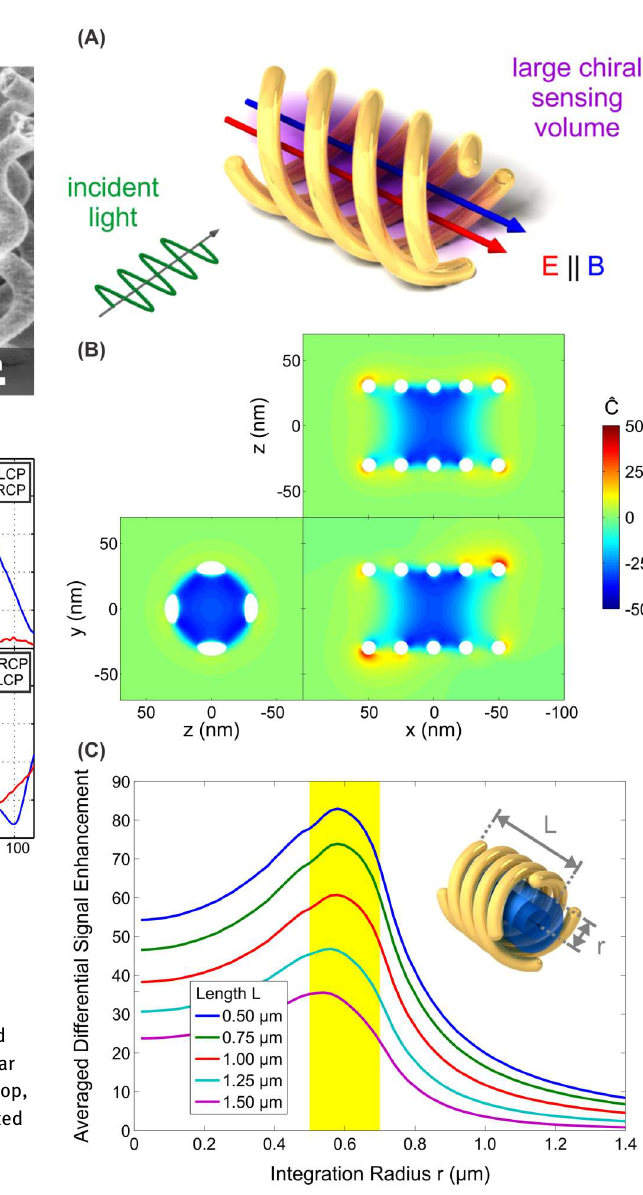
Figure 10: (A) Scheme of chiral near-field source: an N = 4 -helix is excited by a linearly polarized field propagating in a direction or- thogonal to the helix axis. (B) False color plots of the numerically calculated normalized optical chirality for the proposed geometrical parameters. (C) The averaged normalized optical activity is shown for an N = 4 -helix with geometrical parameters that are achievable with DLW. The normalized optical activity was averaged over a cylin- drical volume, defined by the length L and the cylindrical radius r, giving a measure for the enhancement of the chiro-optical response (reprinted with permission from [66]. Copyright 2014